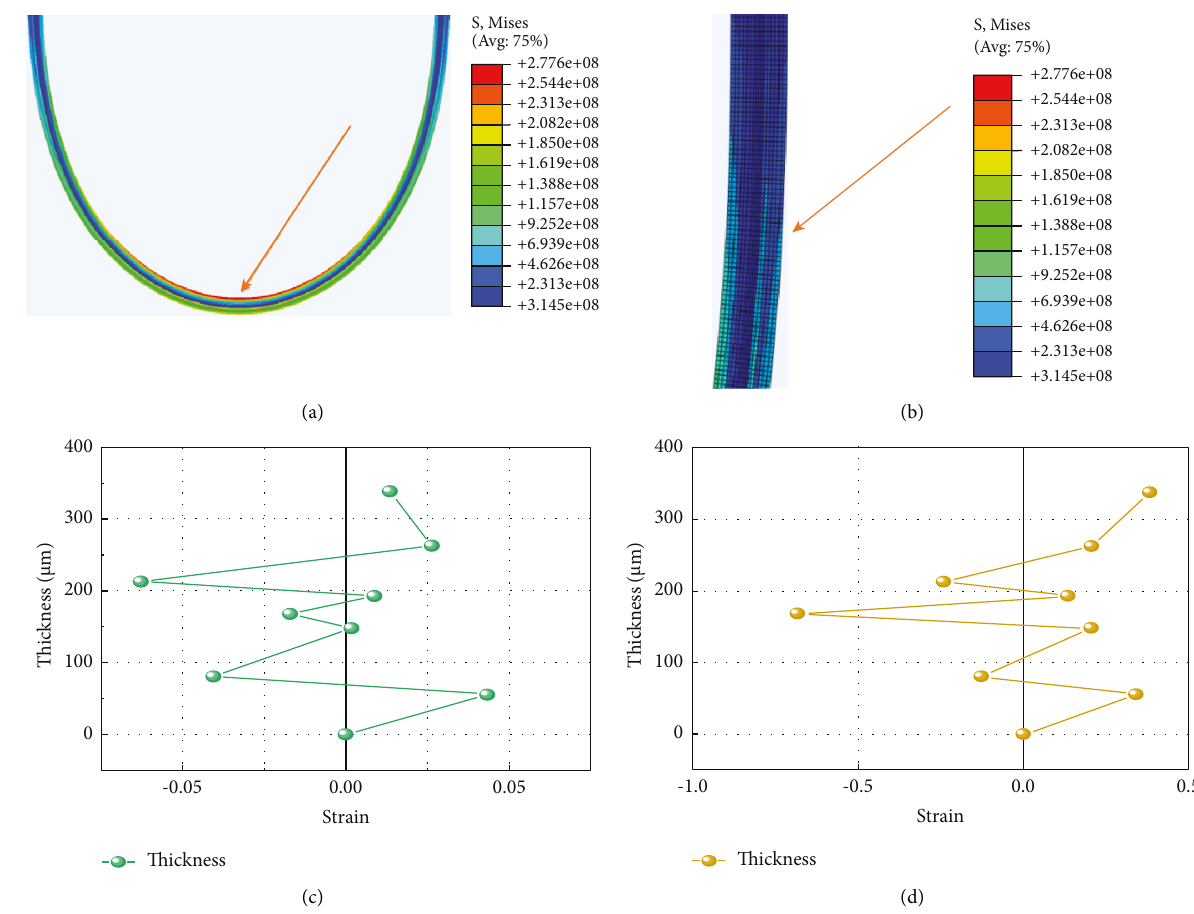
Figure 6: The stress (a) and thickness (c) of the bending area in the U-shaped bend; the tensile stress (b) and the thickness (d) at the end of the u bending